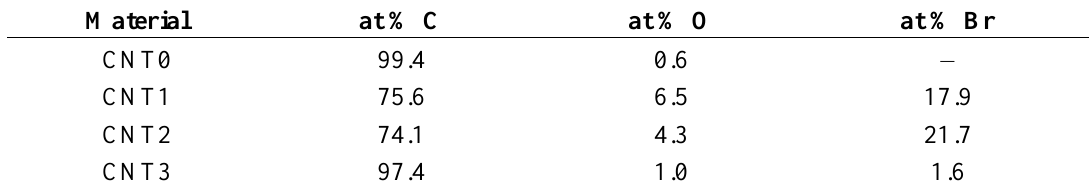
Table 4. Results of X-ray photoelectron spectroscopy (XPS) analyses of the carbon nanotubes (CNT) samples 1–4 prior to indirect